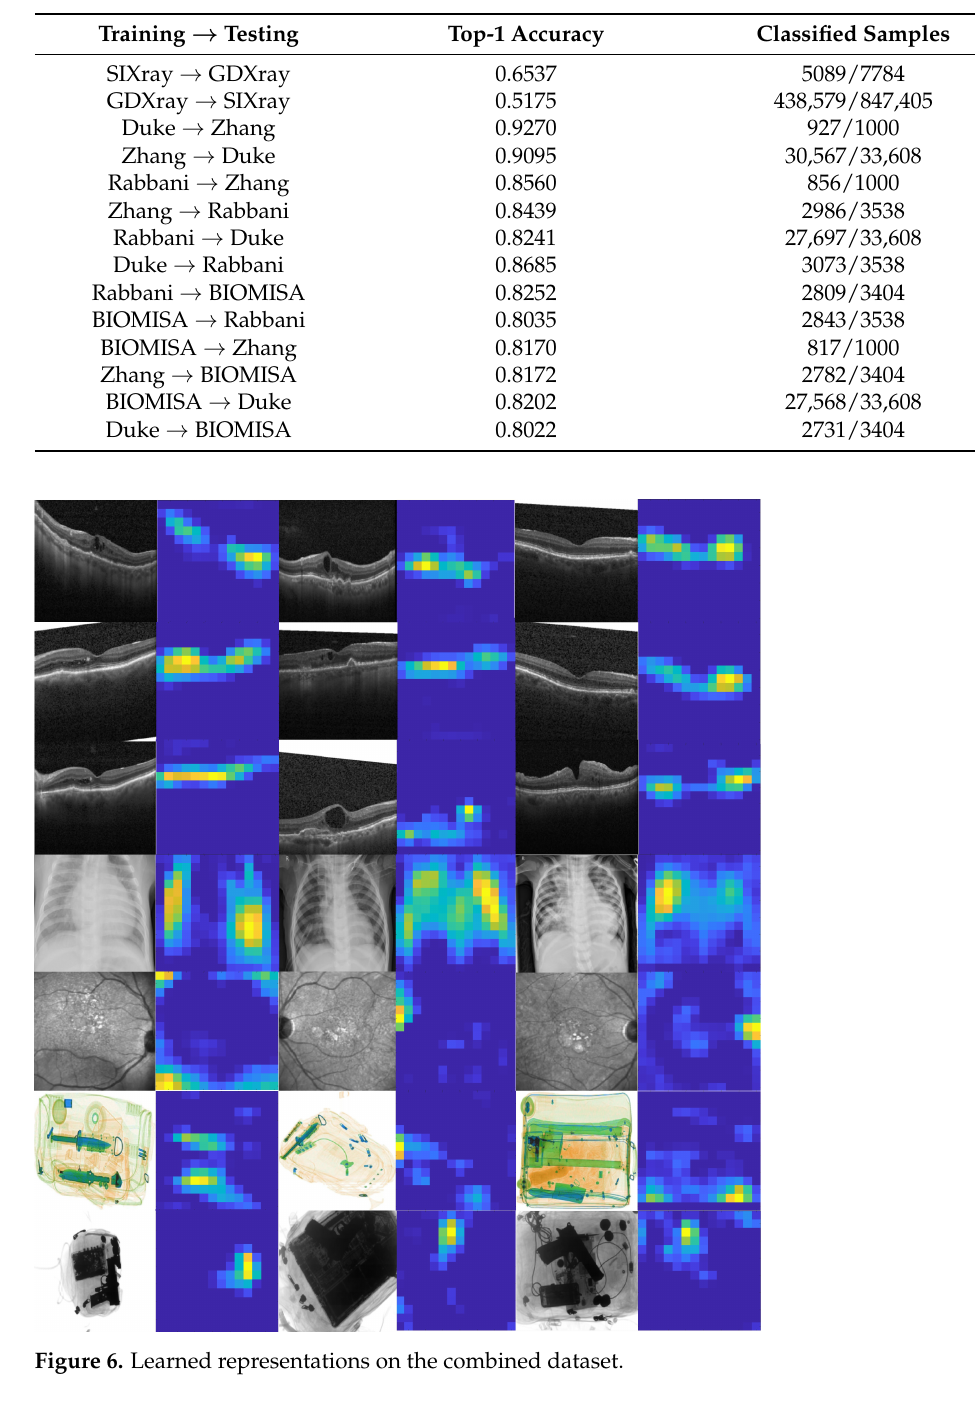
Table 12. Intra-domain transferability analysis. Zhang here only represents the Zhang OCT dataset.